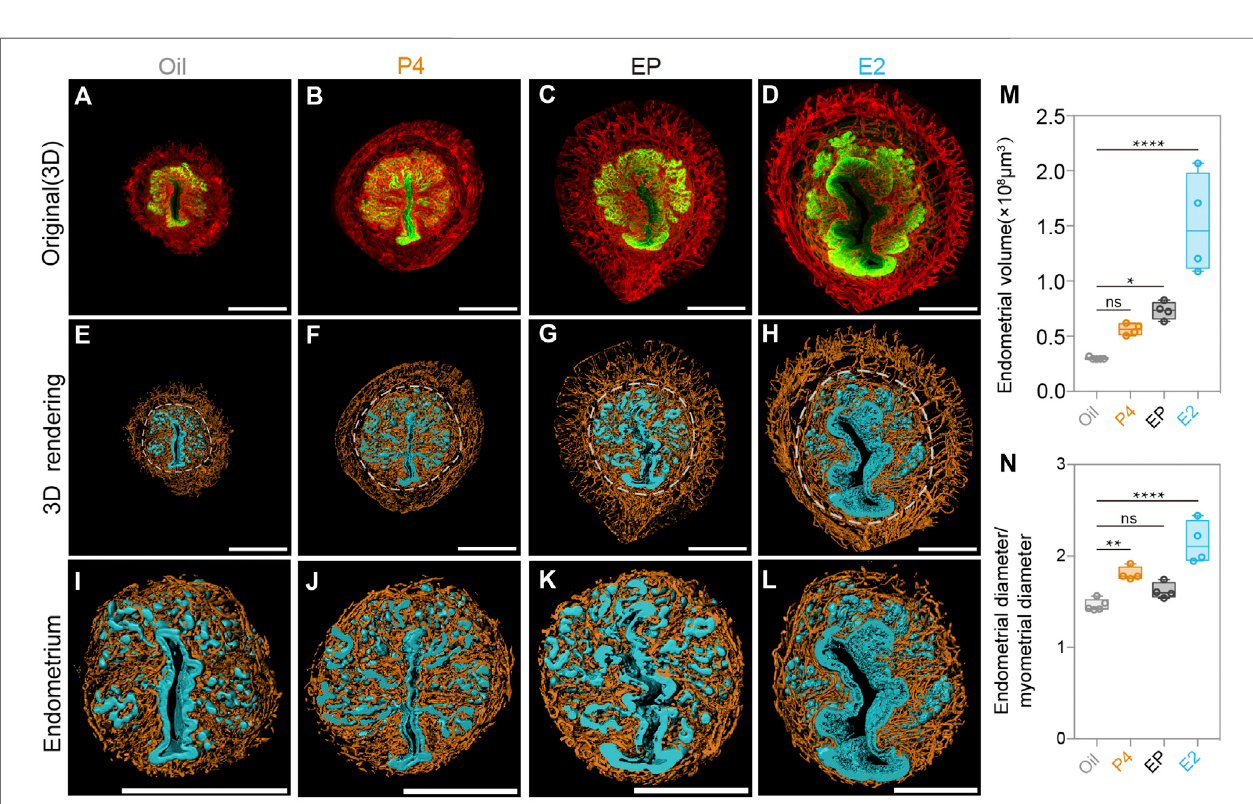
FIGURE5| Uterineendometrialchangesinthe3Dlevelaftersteroidhormonetreatmentinovariectomizedmice. (A – D) 3Dreconstructionoftheuterusaftertheoil- treatedgroup (A) ,P4-treatedgroup (B) ,E2plusP4(EP)-treatedgroup (C) ,andE2-treatedgroup (D) . (E – H) 3Drenderingoftheuterusaftertheoil-treatedgroup (E) ,P4- treatedgroup (F) , E2plus P4 (EP) treated group (G) , and E2-treated group (H) . (I – L) 3D rendering ofuterine endometrial after the oil-treated group (I) , P4-treated group (J) ,E2plusP4(EP)-treatedgroup (K) ,andE2-treatedgroup (L) . (M) Comparingendometrialvolumewithdifferentsteroidhormonetreatments. (N) Comparingthe ratio of the endometrial diameter/myometrial diameter with different steroid hormone treatments. Scale bar of (A – L) = 350 μ m. The results are shown as means ± SEM. Different letters represent signi fi cant differences ( p < 0.05). * p < 0.05, ** p < 0.01, *** p < 0.001, **** p < 0.0001. n ≥ 4.